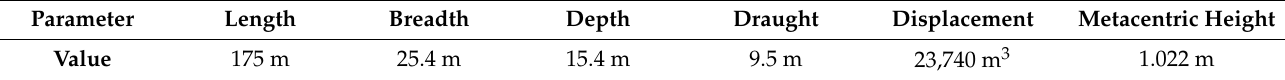
Table 2. S-175 container ship